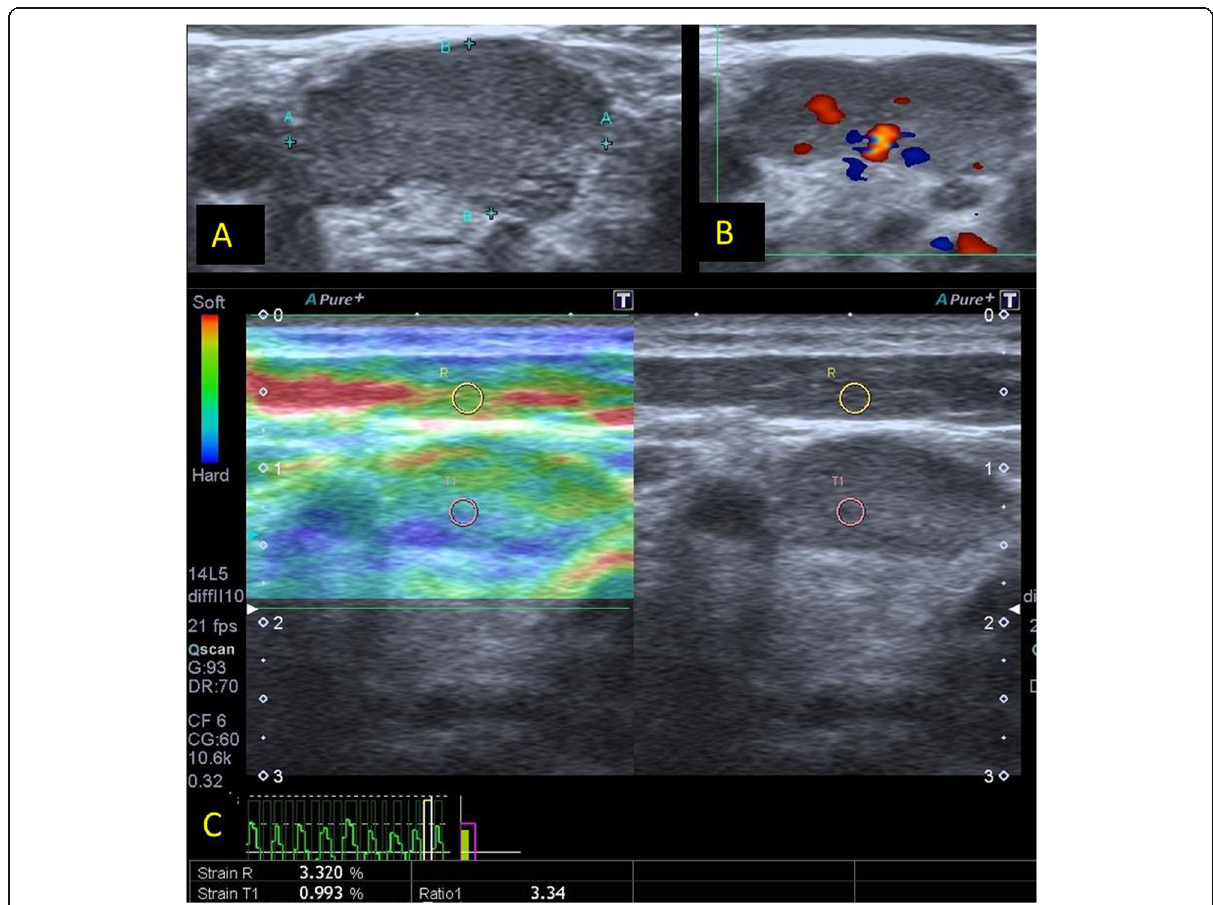
Fig. 4 B-mode US ( a ) revealed a hypoechoic right lower deep cervical lymph node with irregular outline and lost hilum. L/S ratio was 1.9. Color Doppler ( b ) revealed a central pattern of internal vascularity. The split-screen US elastogram ( c ) revealed type 3 color pattern. Strain ratio value was 3.32. The final histopathological diagnosis was nasopharyngeal